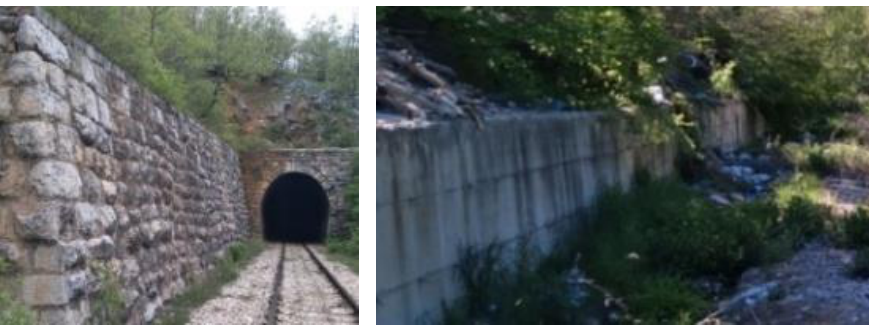
Figure.4. Watersheds shape